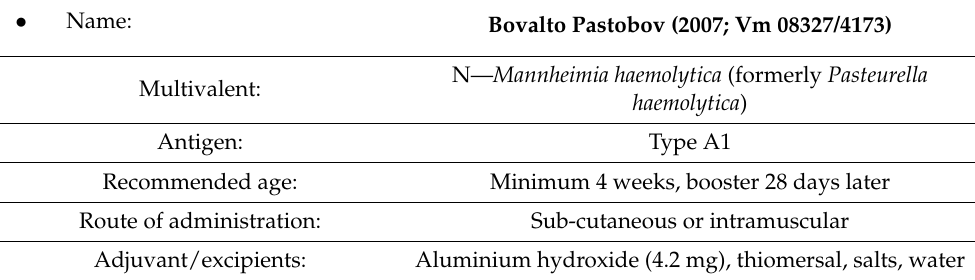
Table A1. Monovalent vaccines for bovine respiratory